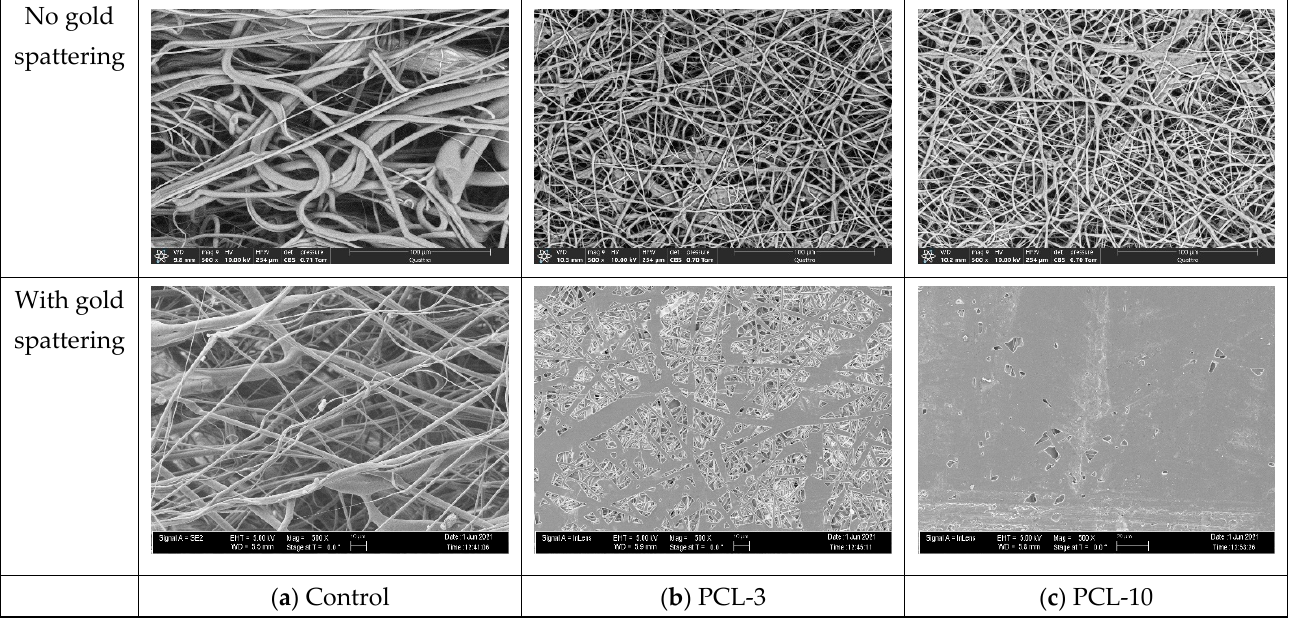
Figure 7. Side by side, SEM images of without and with gold spattering: ( a ) control, ( b ) PCL-3, and ( c ) PCL-10 cloths showing the difference of pores that exist in the samples. All images were taken at 500× magnification.